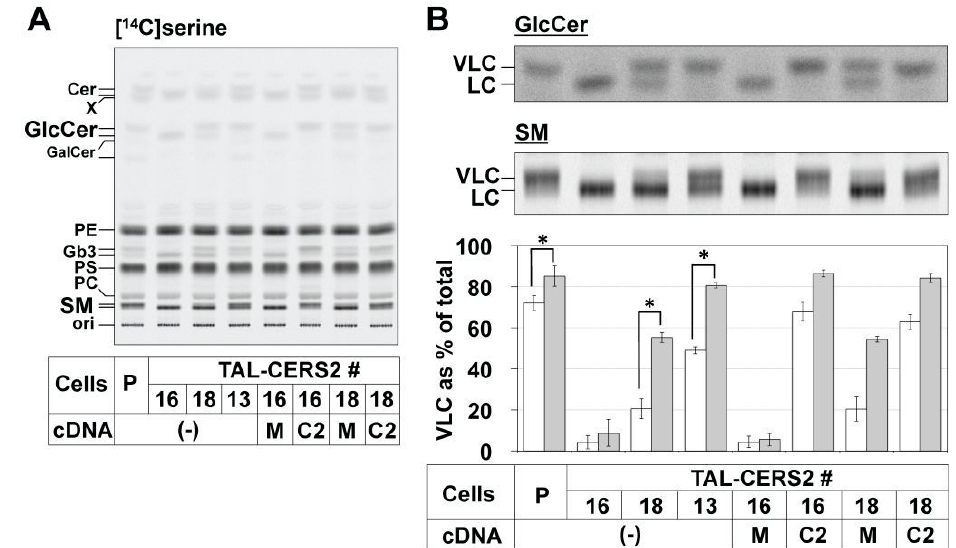
Figure 2. Metabolic labeling of lipids in TAL-CERS2 clones. ( A ) Metabolic labeling of sphingolipids with radioactive serine in the parent cells and TAL-CERS2 clones shown in Figure 1B. Cells were cultured with [ 14 C]serine for 16 h, and lipids extracted from the cells were separated by normal-phase thin-layer chromatography (TLC) (Method 1). Radioactive image of an analyzed TLC plate is shown. Cer, ceramide; GalCer, galactosylceramide; PE, phosphatidylethanolamine; PS, phosphatidylserine; PC, phosphatidylcholine. P, parent cell line; 16, TAL-CERS2#16 clone; 18, TAL-CERS2#18 clone; 13, TAL-CERS2#13 clone; (-), no transfection; M, mock; C2, CERS2 cDNA restoration. The darker image is shown in Figure S3A; ( B ) comparison of the proportion of the upper band intensities (indicating the proportion of very long chain (VLC)) of GlcCer and sphingomyelin (SM). The enlarged and darker images of [ 14 C]serine-labeled GlcCer and SM shown in ( A ) are aligned. The proportions of VLC-containing lipids are expressed as the upper (VLC-containing) band intensity as a percentage of the sum of the upper (VLC) and lower (C16 long chain fatty acid (FA) (LC)-containing) band intensities of GlcCer and SM for each cell line shown in Figure 1B: mean percentage ± standard deviation (SD) obtained from five independent experiments. The Student’s t -test was used. * p < 0.05. To elucidate whether the differential usage of ceramides occurred during the de novo synthesis of sphingolipids, the amount of VLC species as a proportion of the total amount in each sphingolipid